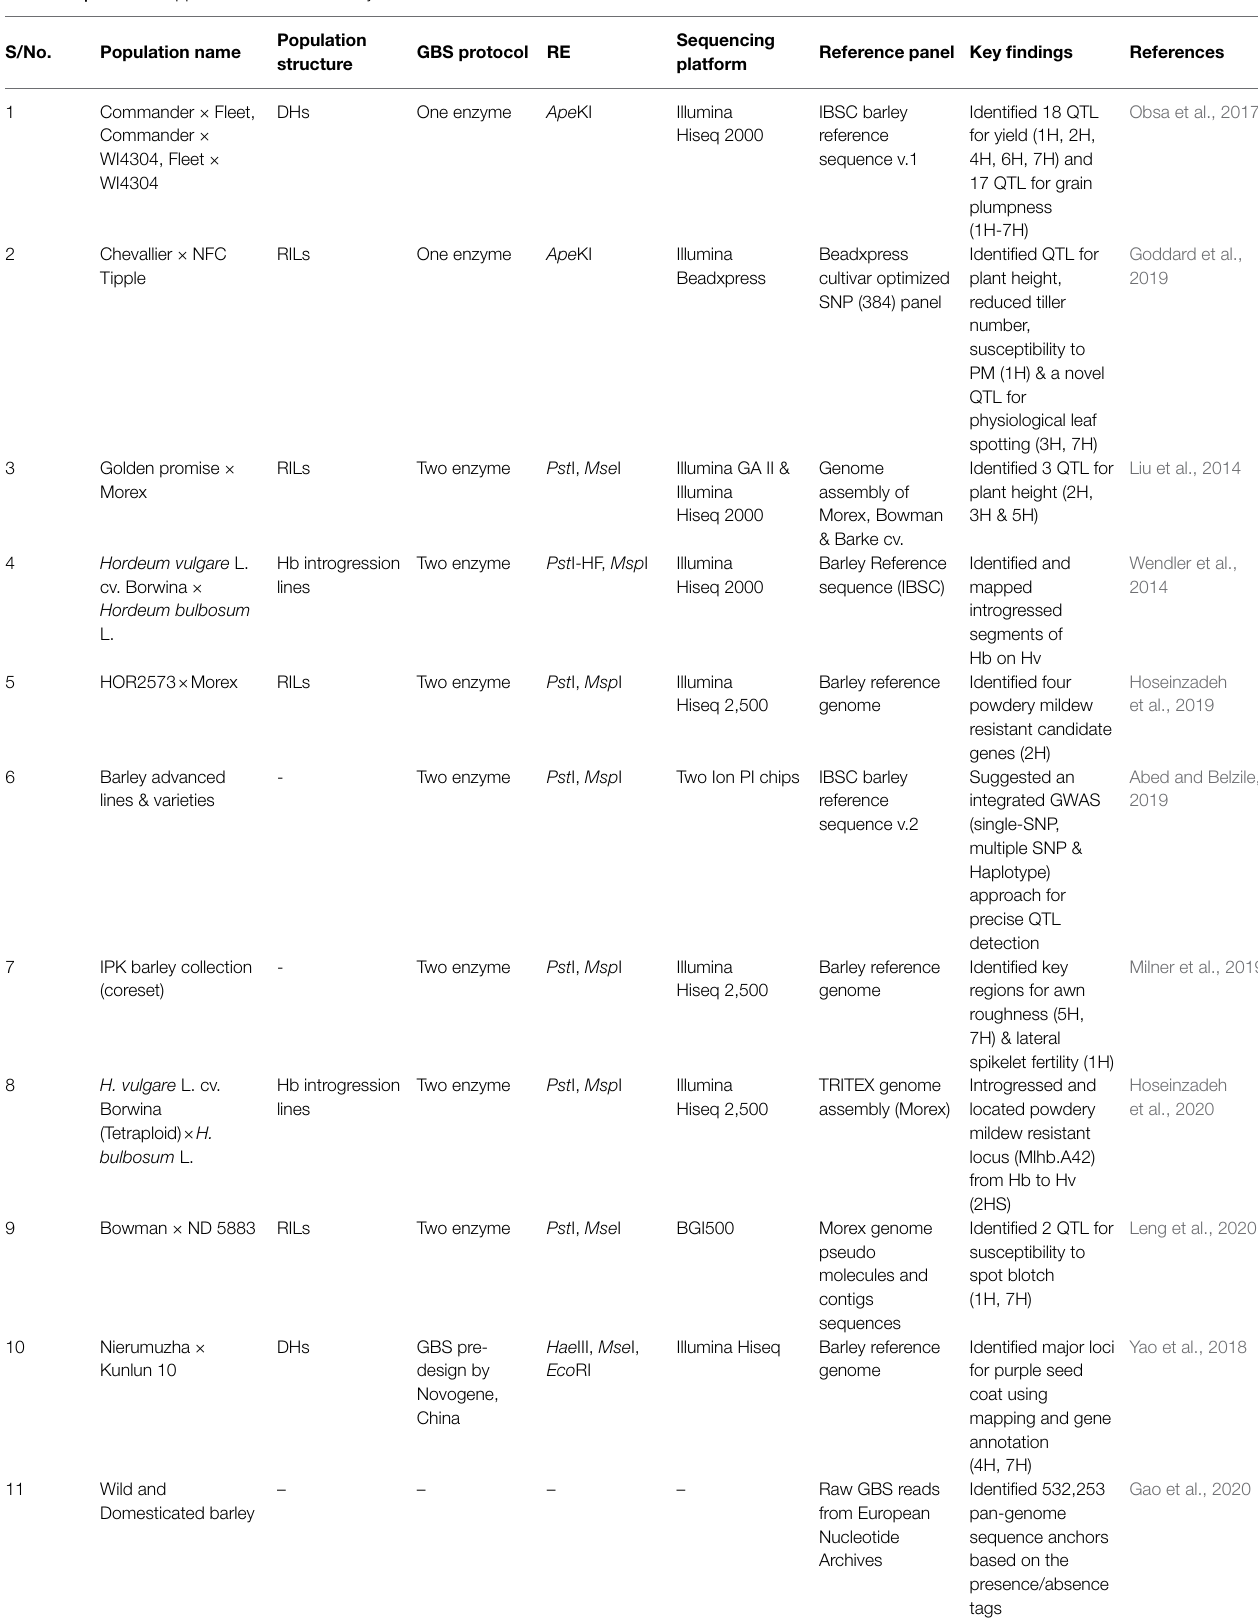
TABLE 2 | Practical application of GBS in barley.